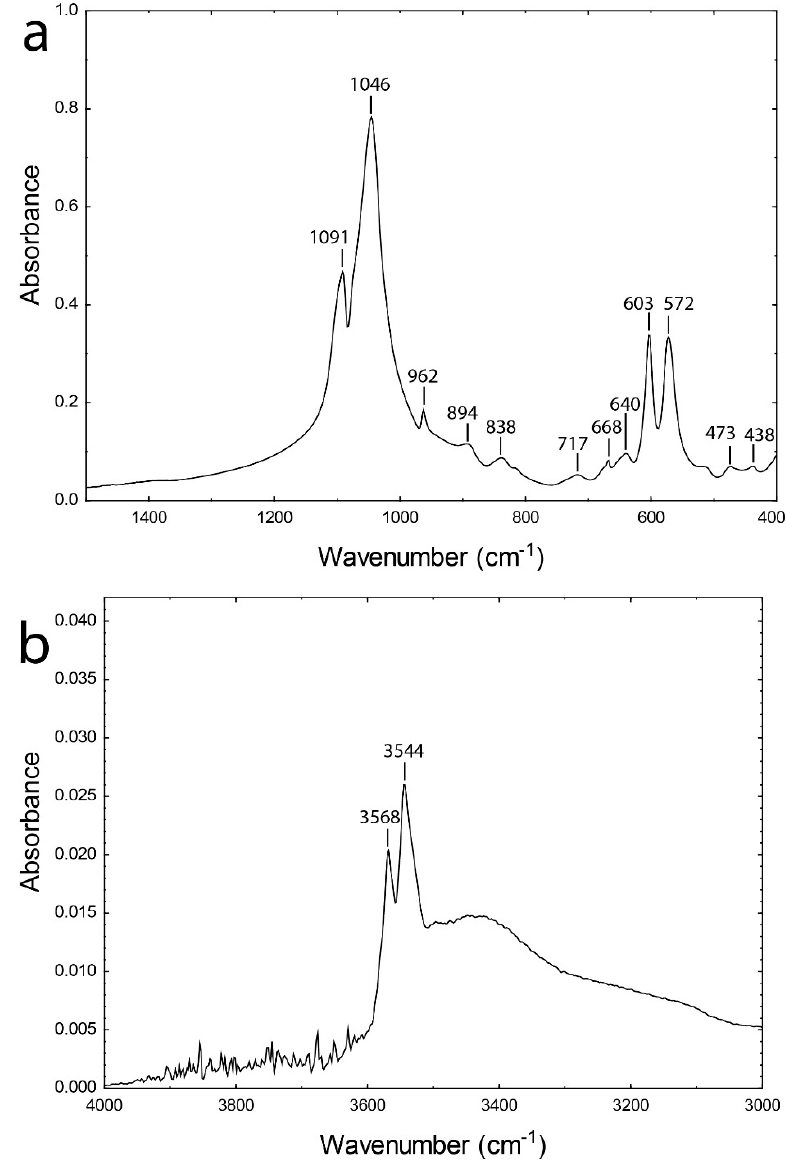
Figure 7. The FTIR spectrum of hydroxylapatite from Muránska Dlhá Lúka. ( a ) 400–1500 cm –1 ; ( b ) 3000–4000 cm –1 .